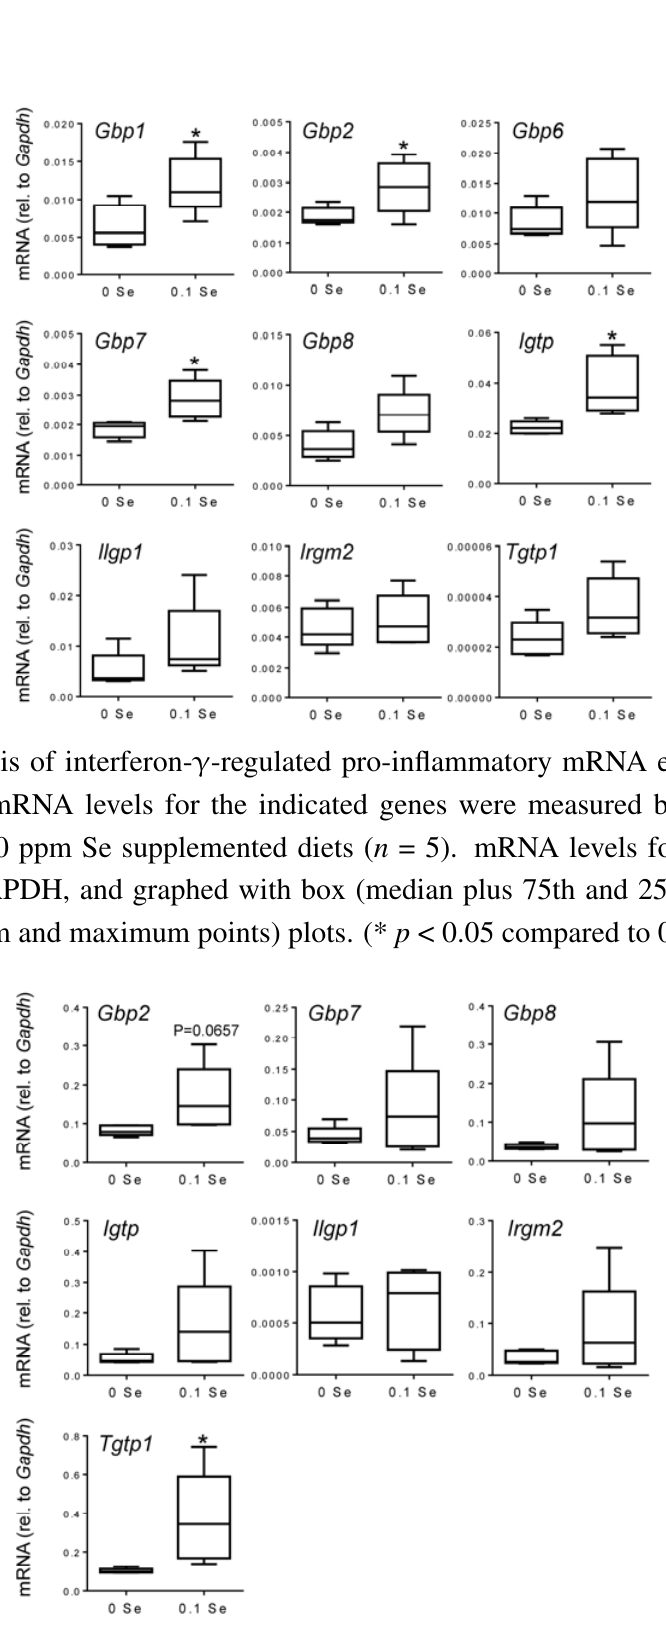
Figure 4. Analysis of interferon- γ -regulated pro-inflammatory mRNA expression in lung by qPCR. Lung mRNA levels for the indicated genes were measured by qPCR for mice fed 0.1 ppm and 0 ppm Se supplemented diets ( n = 5). mRNA levels for each gene were normalized to GAPDH, and graphed with box (median plus 75th and 25th percentile) and whisker (minimum and maximum points) plots. (* p < 0.05 compared to 0 Se).